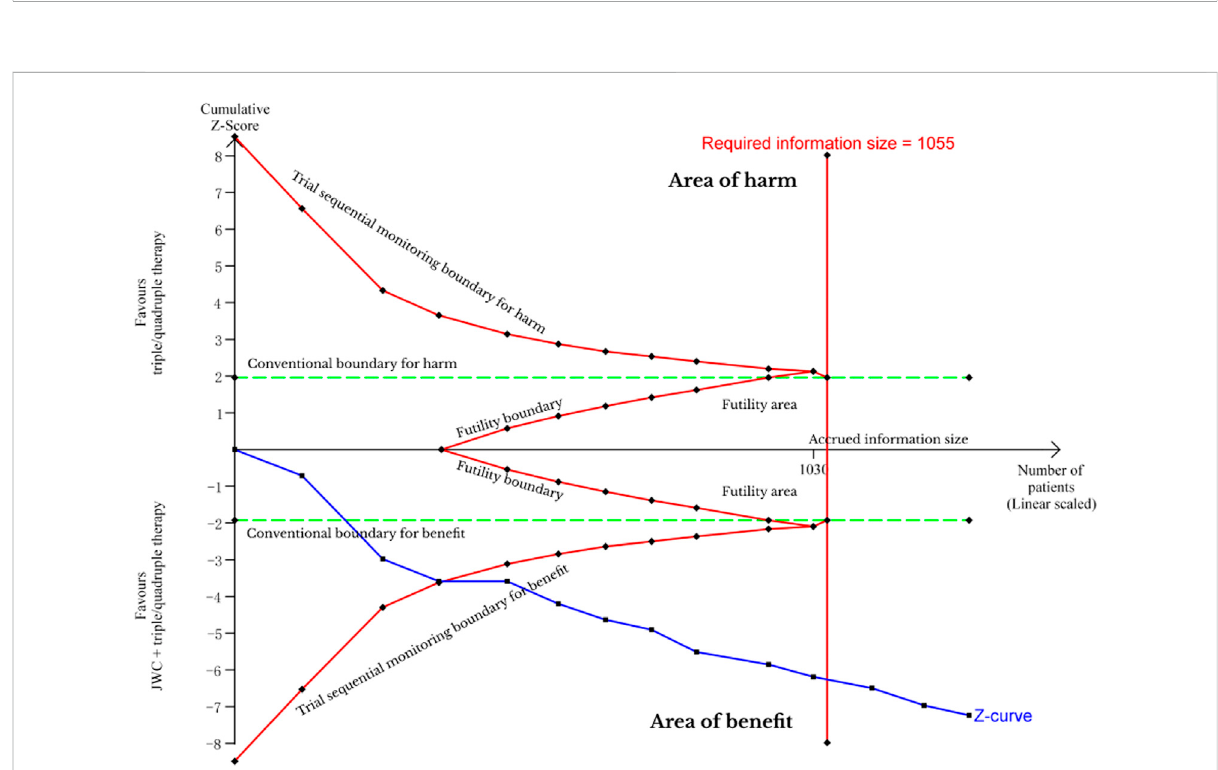
FIGURE 7 Trial sequential analysis of H. pylori eradication rate after JWC with the duration of 4 weeks.